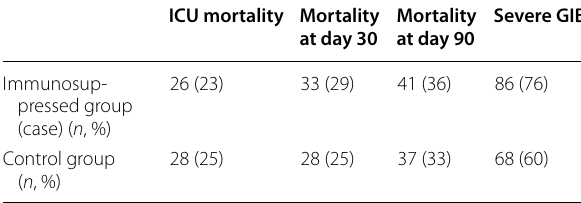
Table 3 Number of events case–control after matching